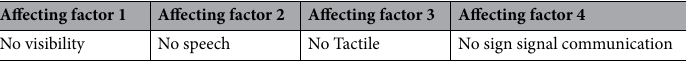
Table 1. Possible factors affecting